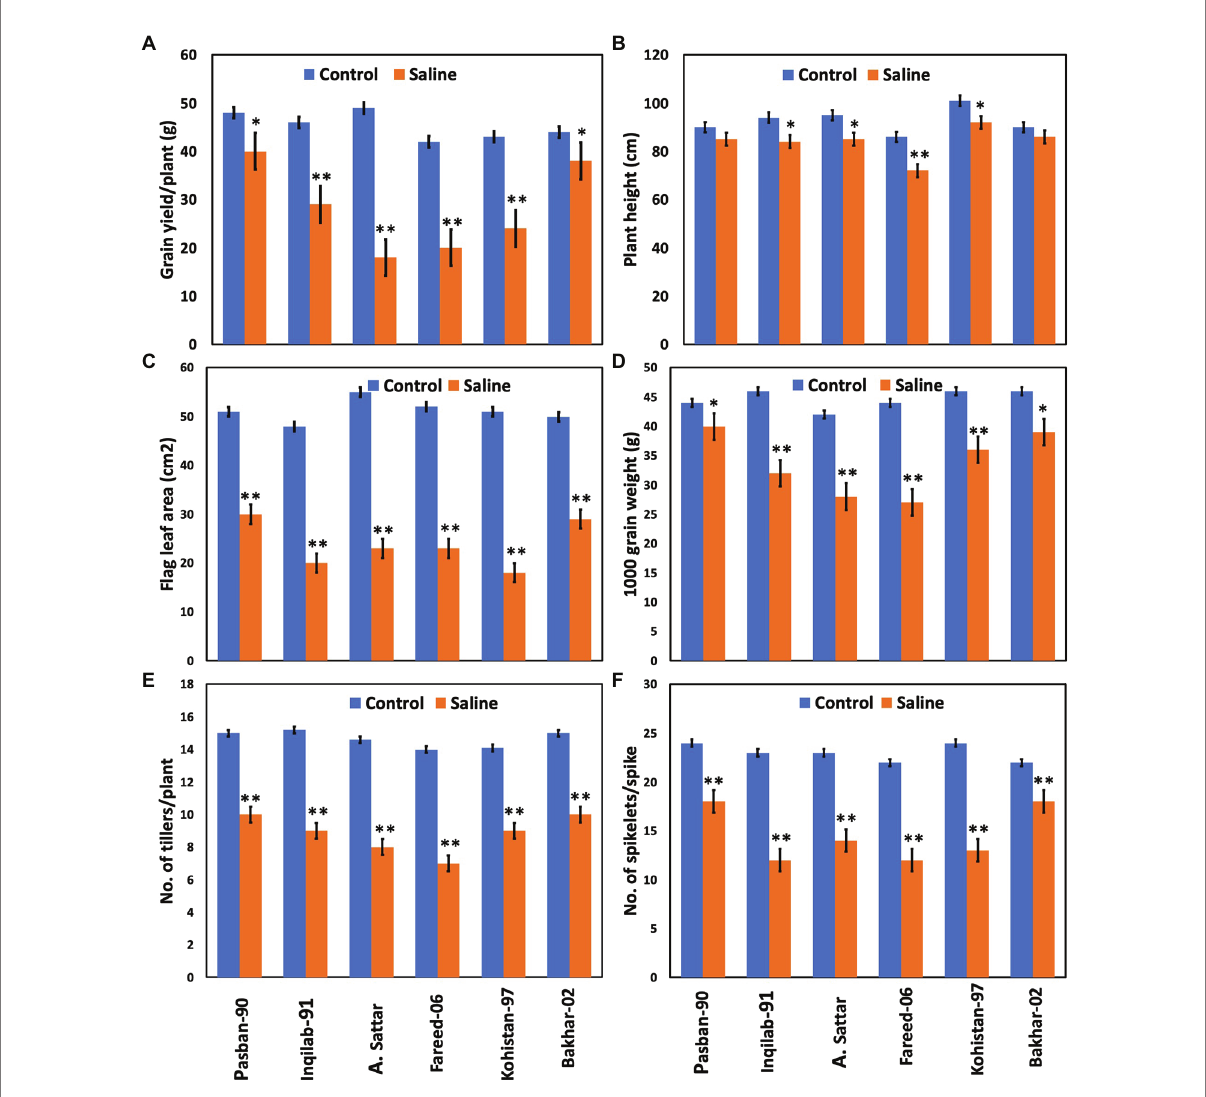
FIGURE 3 Yield attributes of wheat varieties at the maturity stage under salt stress (150 mM) and control condition (0 mM). (A) Grain yield/plant, (B) plant height, (C) flag leaf area, (D) 1,000 grain weight, (E) no. of tillers/plant, (F) no. of spikelet’s/spike. Bars indicate ±. Mean values are indicated on the vertical axis. Asterisks (**) indicate that the trait mean was significantly different (value of p < 0.01) between the salt and control